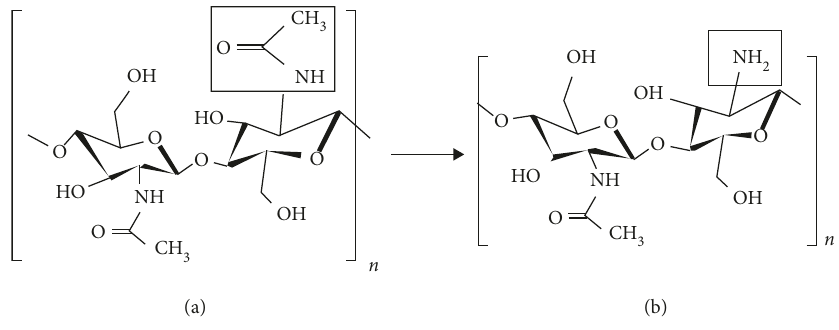
Figure 1: Chemical structures of chitin (a) and chitosan